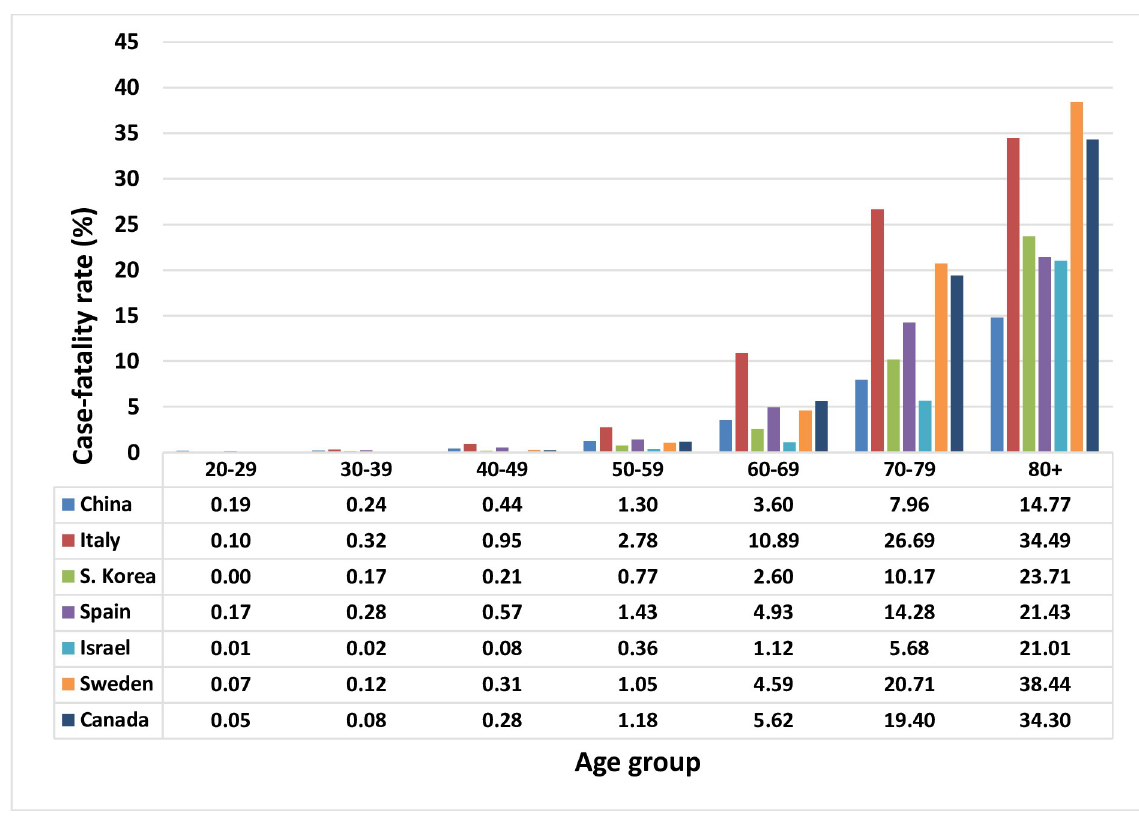
Fig 2. Age specific case-fatality rates (%) for seven countries–China, Italy, S Korea, Spain, Israel, Sweden, and Canada.